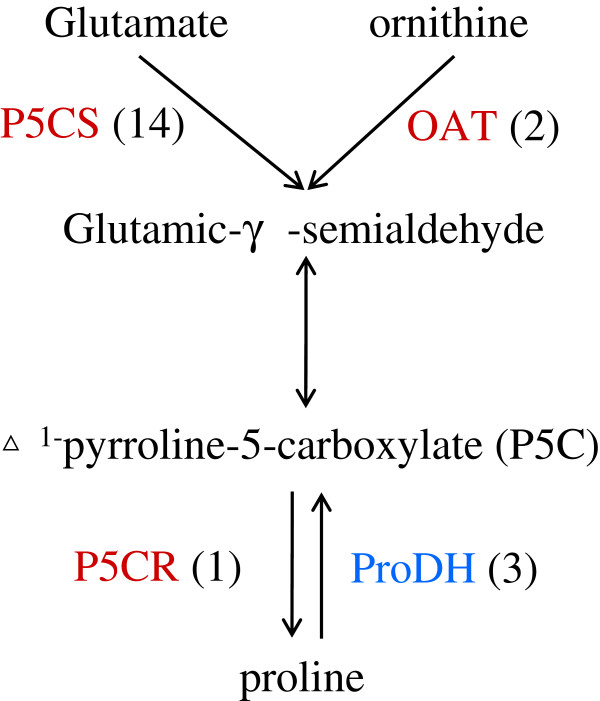
Proline biosynthetic pathway in chrysanthemum under dehydration. P5CS, pyrroline-5-carboxylate synthetase; P5CR: pyrroline-5-carboxylate reductase; ProDH, proline dehydrogenase; OAT, ornithine aminotransferase. Genes in red and blue mean up- and down-regulated by dehydration, respectively. Numbers in brackets represent numbers of unique transcript regulated by dehydration stress.